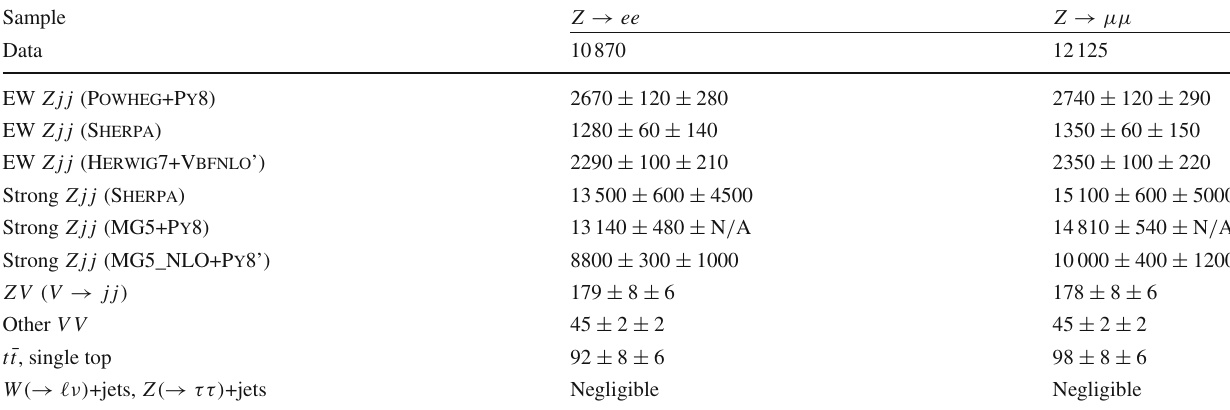
Table 2 Observed and expectedevent yields inthe dielectronand dimuon decay channels following the event selectiondescribed inSect. 4. The first (second) uncertainty quoted for each generator is the experimental (theoretical) systematic uncertainty. The experimental systematic uncertainties are shown for each prediction. Theoretical uncertainties are calculated for all predictions except for MG5+P y 8 strong Zjj , which is denoted ‘N/A’ in the table. The statistical uncertainty on each prediction is